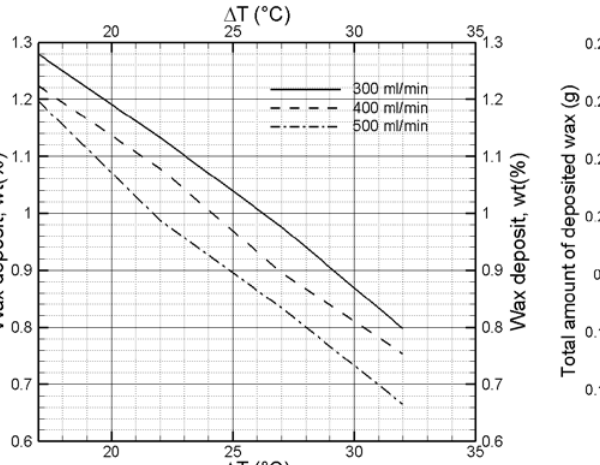
Figure 8 Effect on wax deposit due to temperature differential (Nazar et al.,